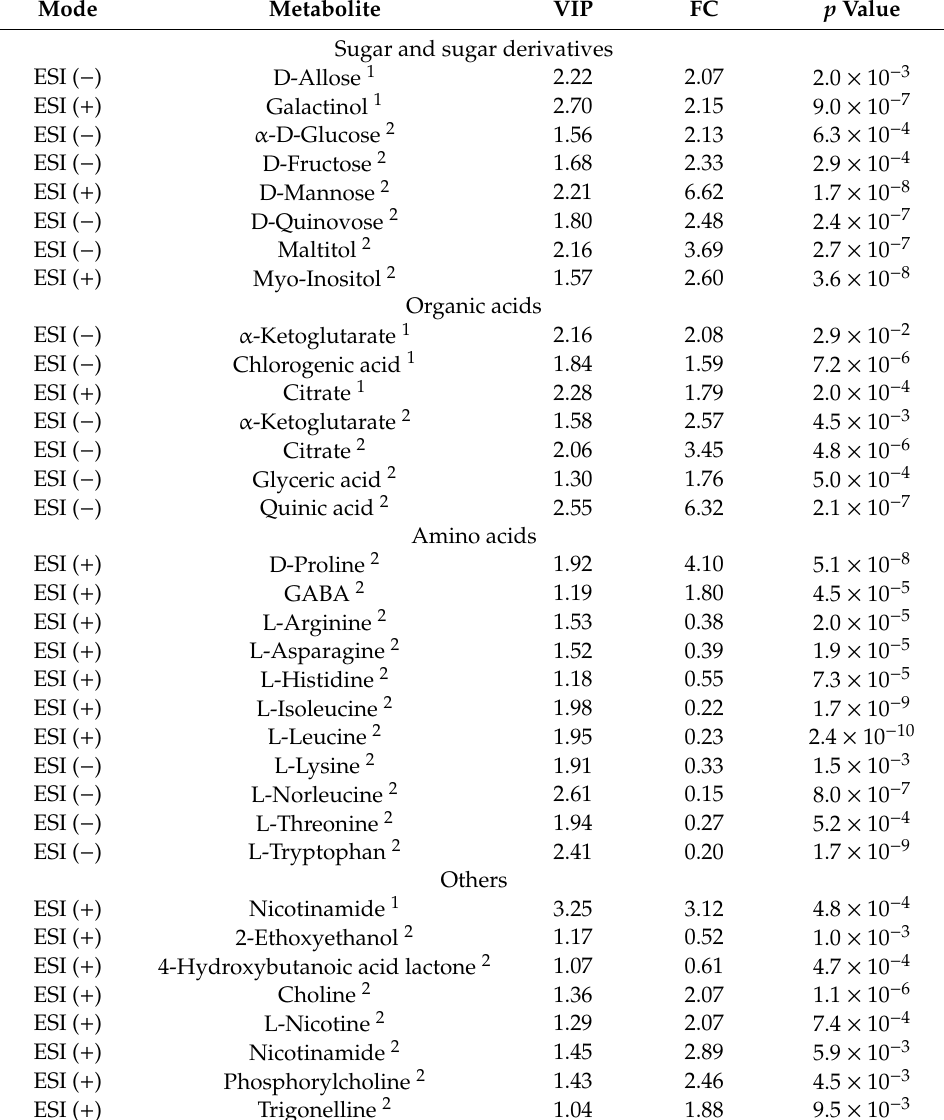
Table 2. List of the significantly changed metabolites between COR-treated and non-treated tobacco seedlings under normal growth conditions and PEG stress. VIP = variable importance in projection; ESI = electrospray ionization